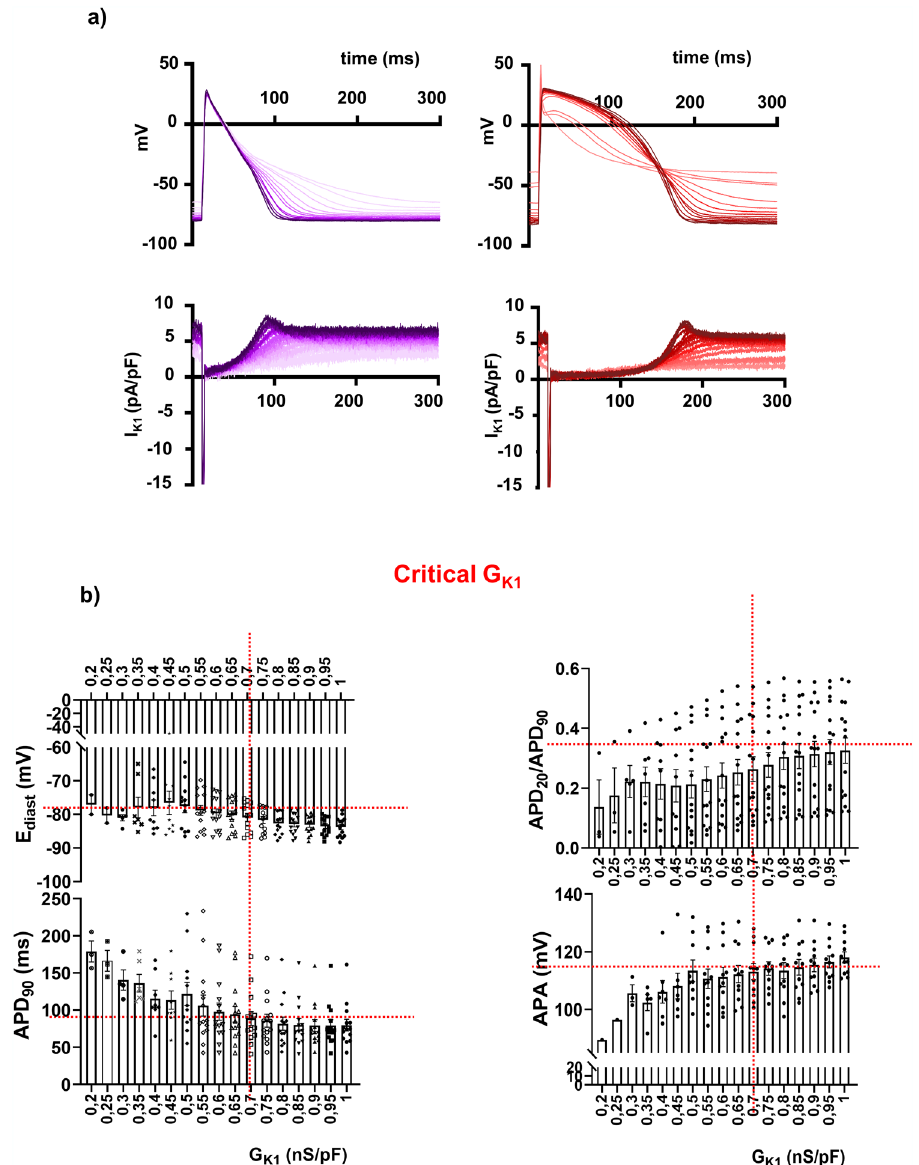
Fig. 2 G K1 parameter setting of I K1_Atr model. a Examples of evoked shorter (atrial-like) and longer (ventricular-like) AP pro fi les following progressive increase of G K1 ranging from 0.2 to 1 nS/pF (0.05 nS/pF step). Light colour code for low G K1 values and dark colors code for high G K1 values. b E diast , APD 90 , APD 20 /APD 90 and APA changes yielded from all cardiomyocytes ( n = 3 differentiations, n = 3-14 cells, depending on the cell stability at lower G K1 ) are represented against G K1 values. Red dashed line identi fi es the critical G K1 value (vertical lines) to reach stable AP parameters (horizontal lines shows the steady state of speci fi c parameter obtained injecting critical G k1 ). APD 90 AP duration measured at 90% of the repolarisation phase, E diast diastolic membrane potential, APD 20 AP duration measured at 20%, APD 20 /APD 90 ratio, APA AP amplitude, G K1 , I K1 conductance. Data are presented as mean ±